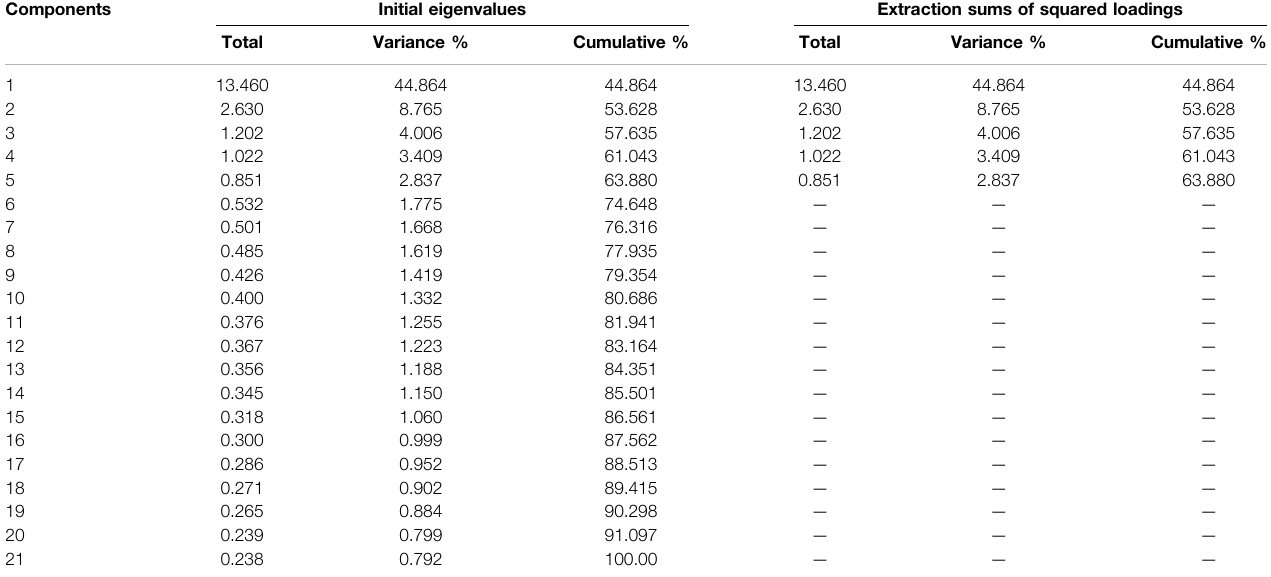
TABLE 7 | Total variance